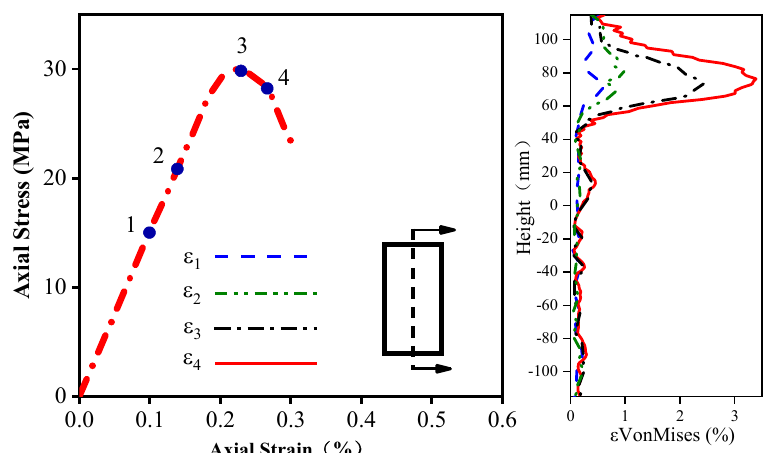
Figure 10. The evolution of the Von Mises strain on the unconfined specimens.